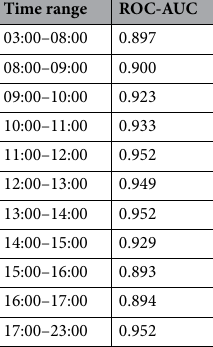
Table 7. Performance (AUC) measured on frames acquired at different hours of the day for the convLSTM model.